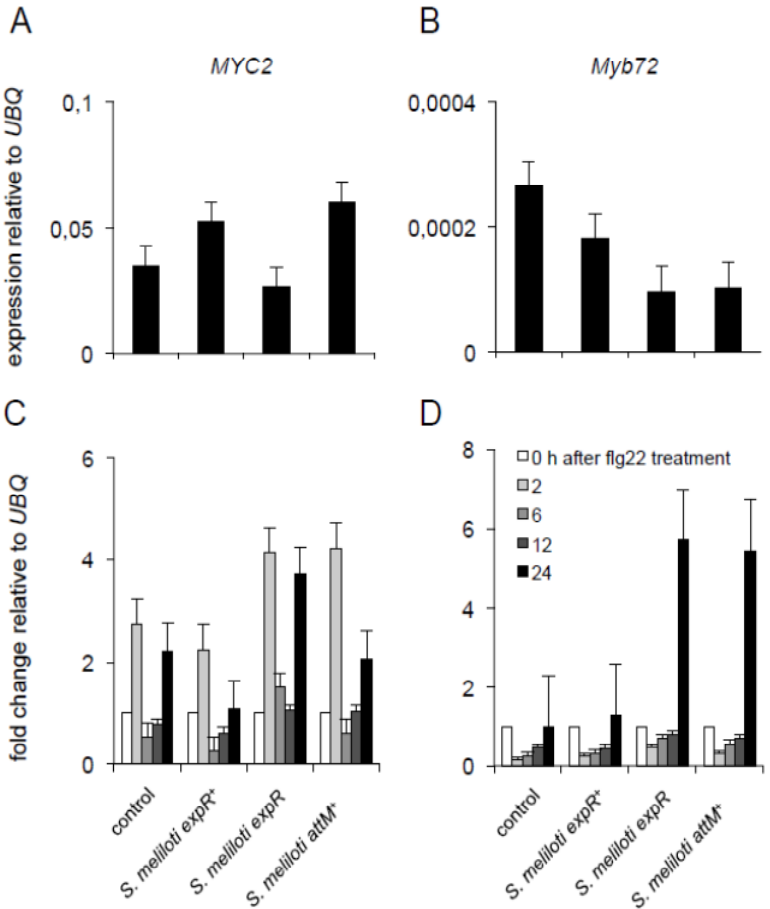
Figure 5. Expression of two Induced Systemic Resistance (ISR) related genes. Two-week-old Arabidopsis seedlings were pre-treated with AHL extract from different S. meliloti cultures, and challenged with 100 nM flg22. ( A ) and ( B ) Expression levels of MYC2 ( A ) and Myb72 ( B ) after 3 days of pre-treatment; ( C ) and ( D ) Expression levels after the secondary challenge with 100 nM flg22. All values were normalized to the expression of UBQ gene. Graphs present a representative experiment from three independent